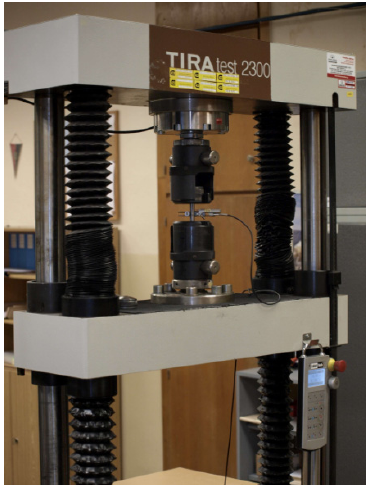
Figure 2. Universal testing machine—Tira Test 2300.